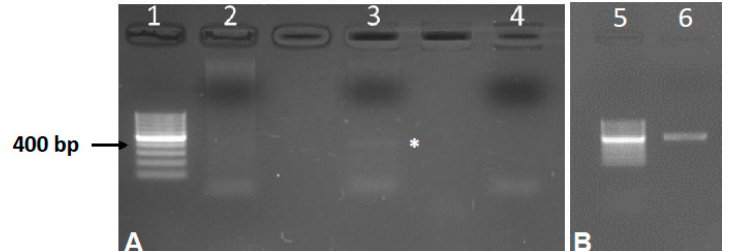
Figure 2. Agarose gel electrophoresis of the PCR amplification of DNA extracted from gills of Danio rerio . ( A ) PCR conducted using the primer pair ITS2_Centr_F/ITS2_Centr_R. (1) 100 bp ladder, (2) DNA extracted from uninfected gills, (3) DNA extracted from infected gills, (4) negative control (without DNA). The asterisk indicates the amplification fragment; ( B ) PCR conducted using the primer pair 3S/BD2. (5) 100 bp ladder and (6) DNA extracted from infected gills.